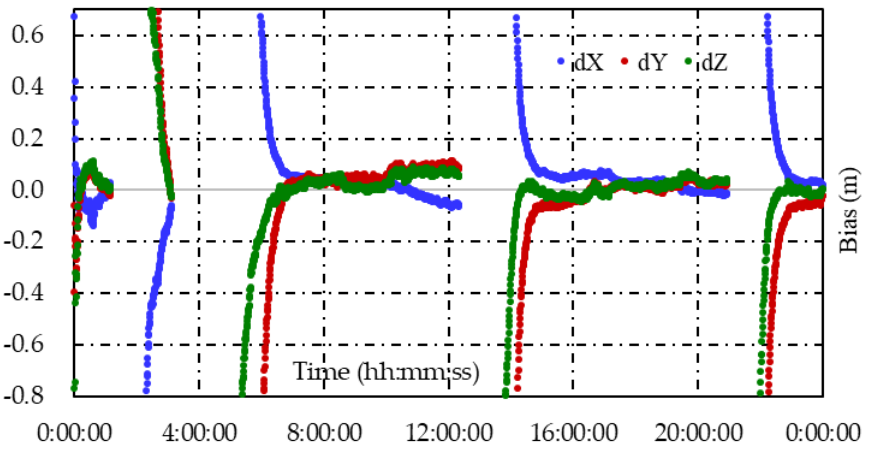
Figure 25. Coordinate biases from kinematic PPP with method B with respect to Figure 11 (process noise of 2500 m 2 is set for receiver clock error).